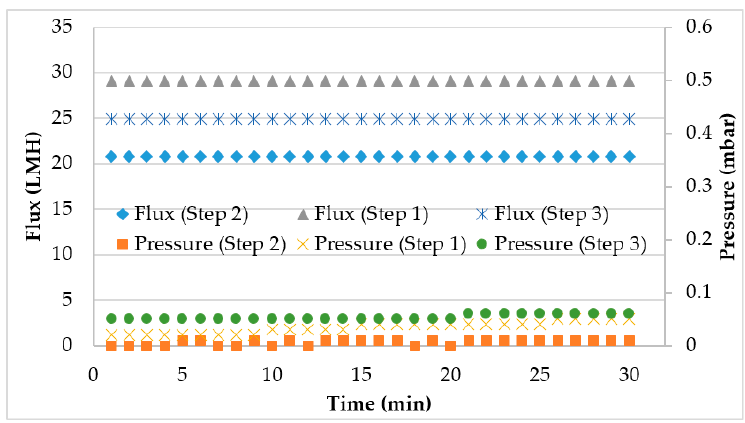
Figure 5. Flux pressure profile of UF 250 kDa membrane.